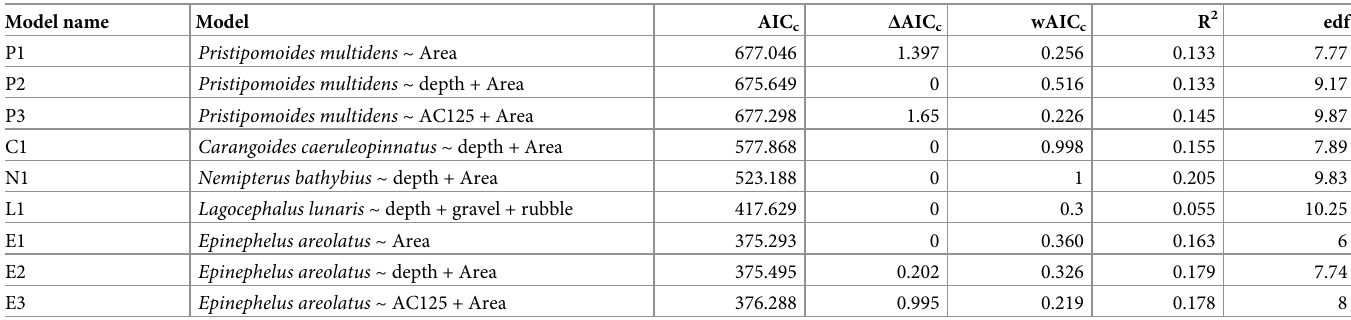
Predictors included: AC125 position, Area, depth, proportional cover of benthic biota, mud/silt, gravel, rubble and boulder/reef substrate. All other conventions